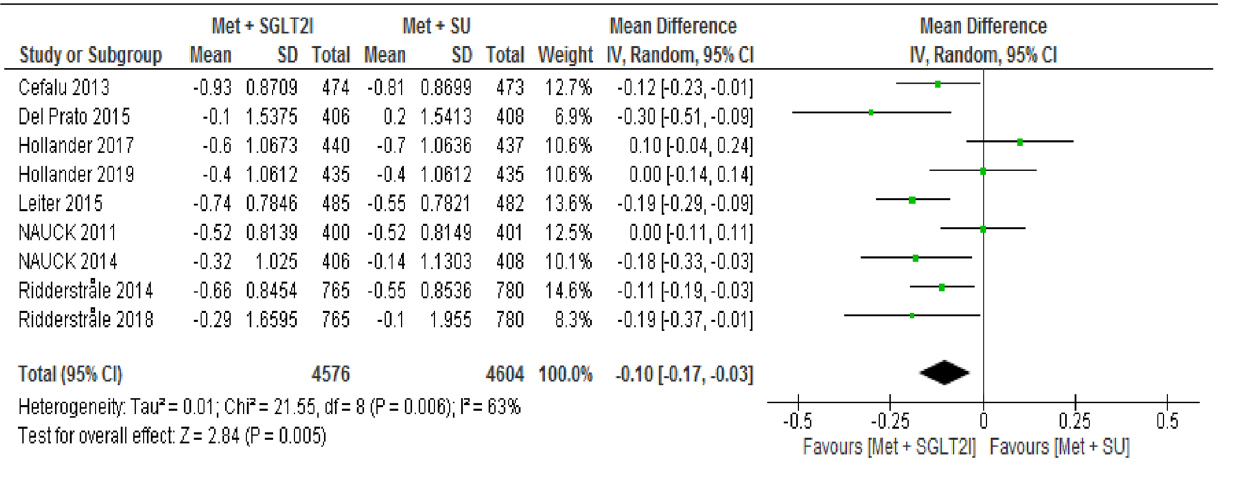
Figure 9. Comparison of change in HbA1c (%) from baseline between patients who were on metformin- SGIT2I and metformin-sulphonylureas combination therapies. SD standard deviation; CI confidence interval; MD mean difference; Met metformin; SGLT2I sodium glucose co-transporter 2 inhibitor; SU